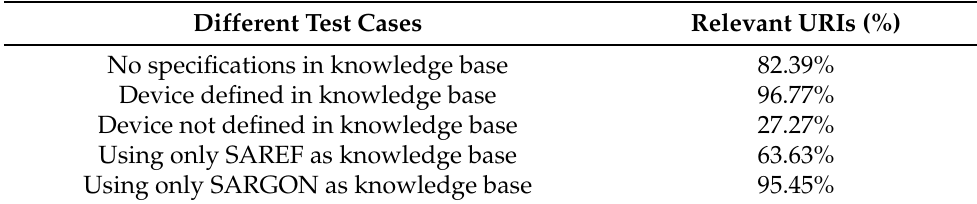
Table 1. SiSEG assessment